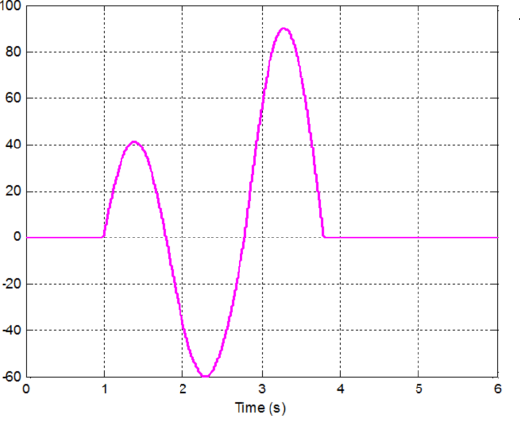
Fig. 9: Steering wheel angle input ( δ = 0 and δ (cid:54) = 0) .